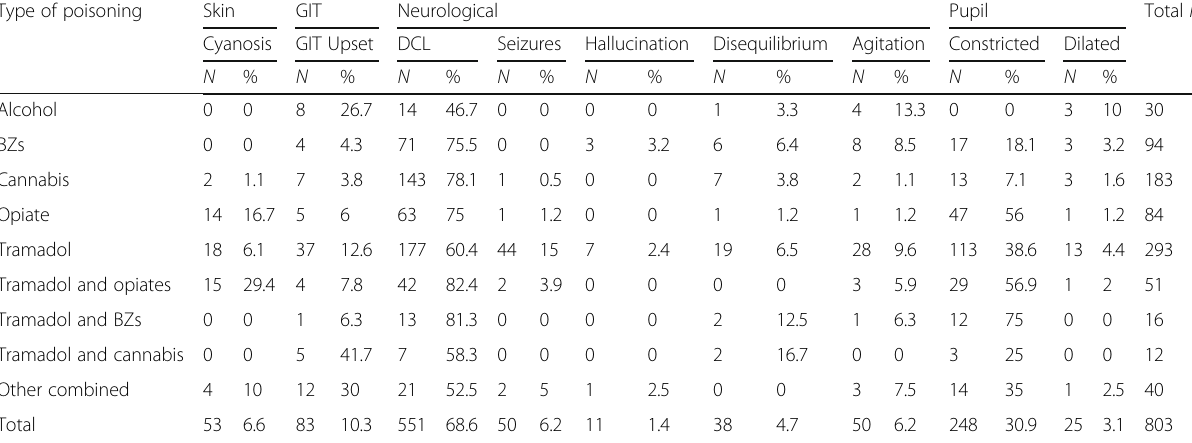
Table 4 Description of Clinical presentation among all patients with different types of